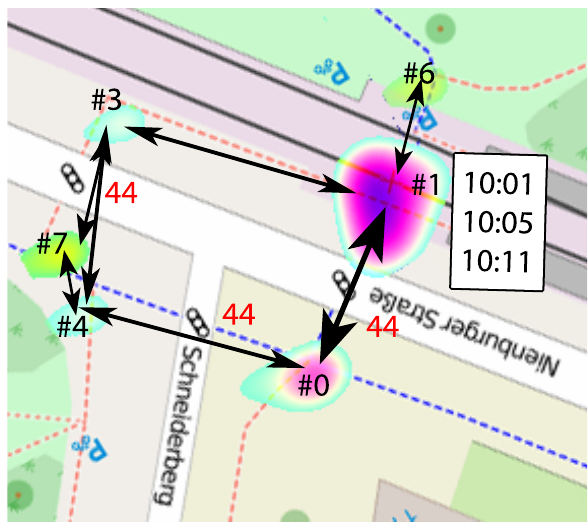
Figure 1: Snapshot of dynamic map